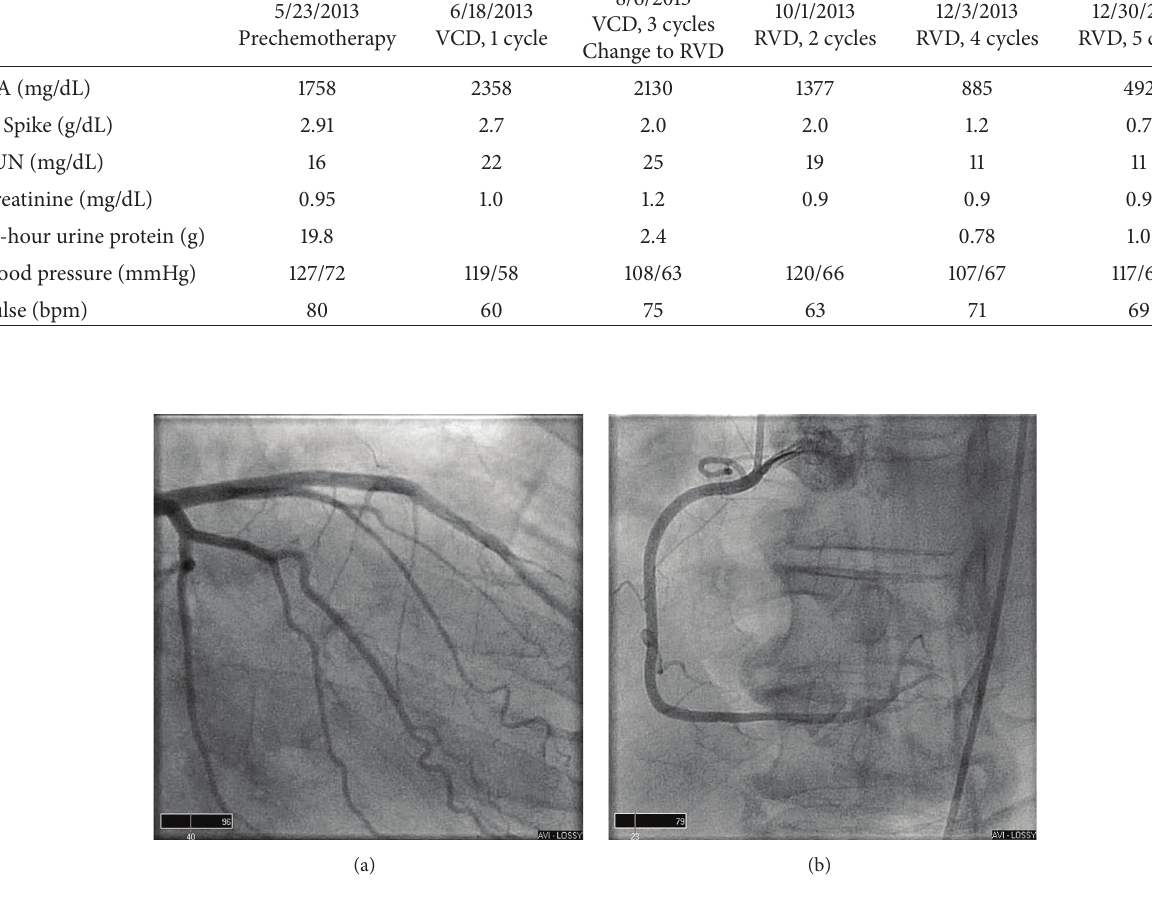
Figure 3: Coronary angiograms show no obstructive lesions in (a) the left anterior descending and the left circumflex artery or (b) the right coronary